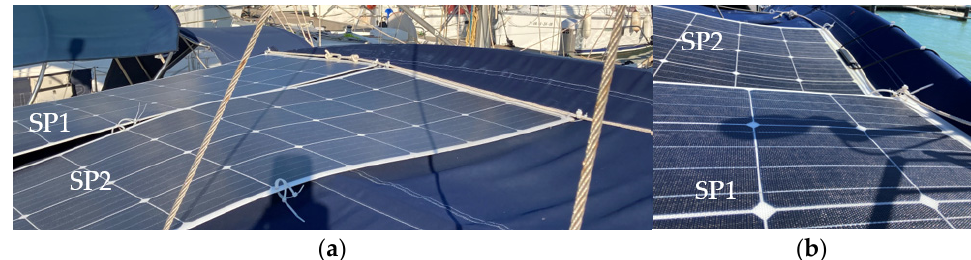
Figure 13. Projection of ( a ) backstay and ( b ) antenna shading lines on SP1 and SP2 in the early hours of the day (9:30 a.m.).